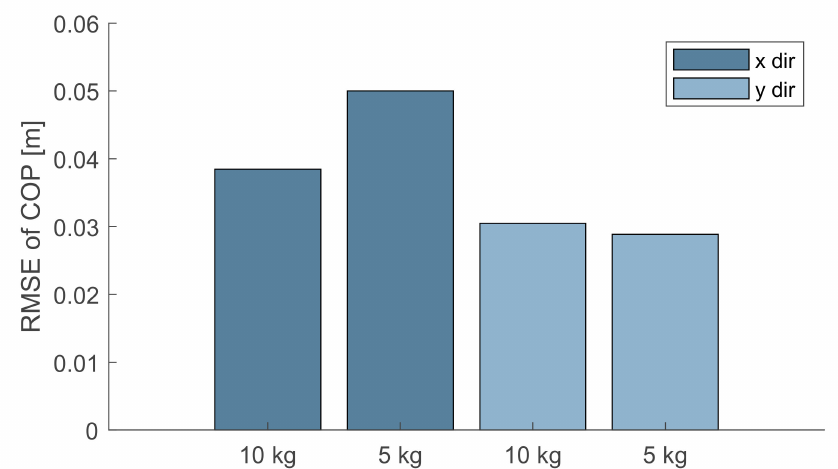
Figure 8. RMSE between COP